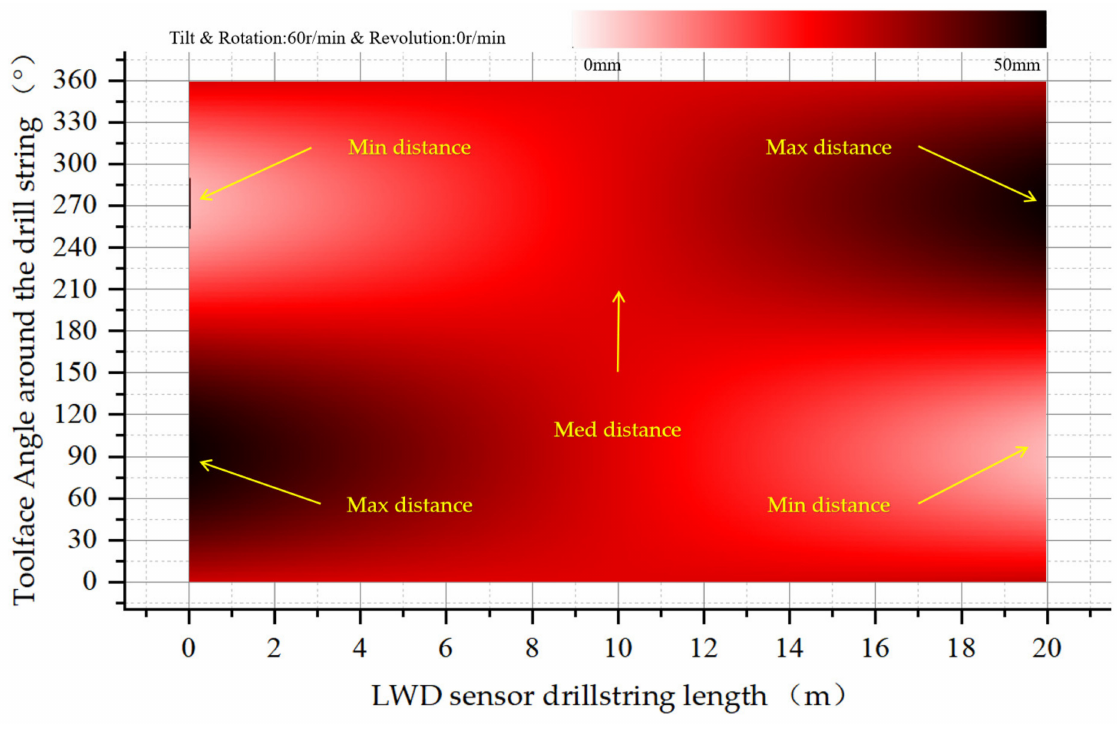
Figure 12. Eccentricity distribution of drill collars as they tilt in the